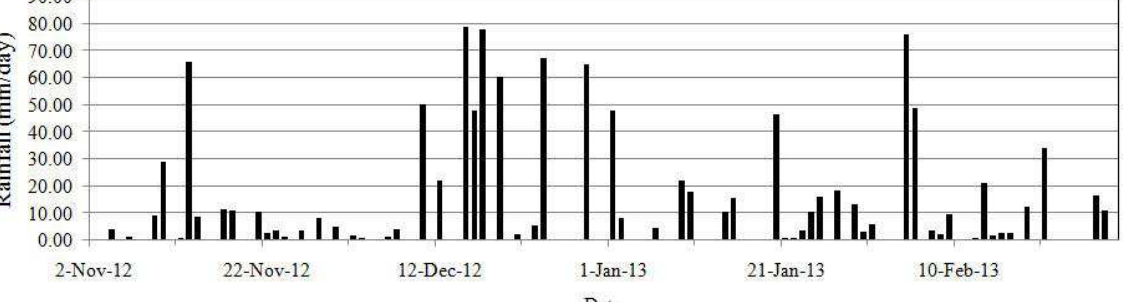
Fig. A1.1. Quantities of daily rainfall in the study area from November 2012 to February